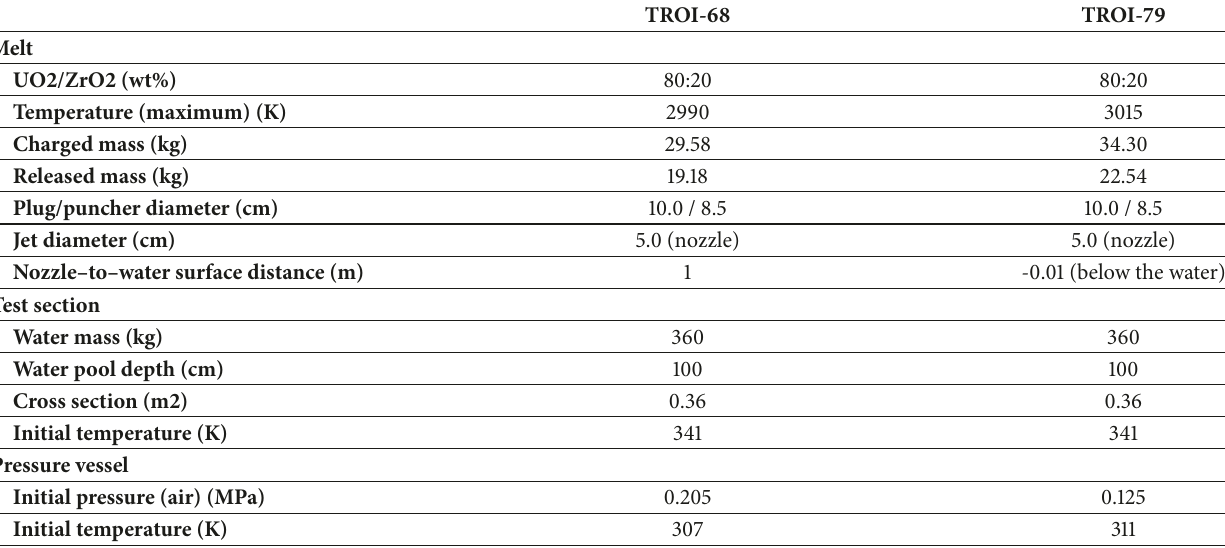
Table 1: Initial conditions in TROI tests.